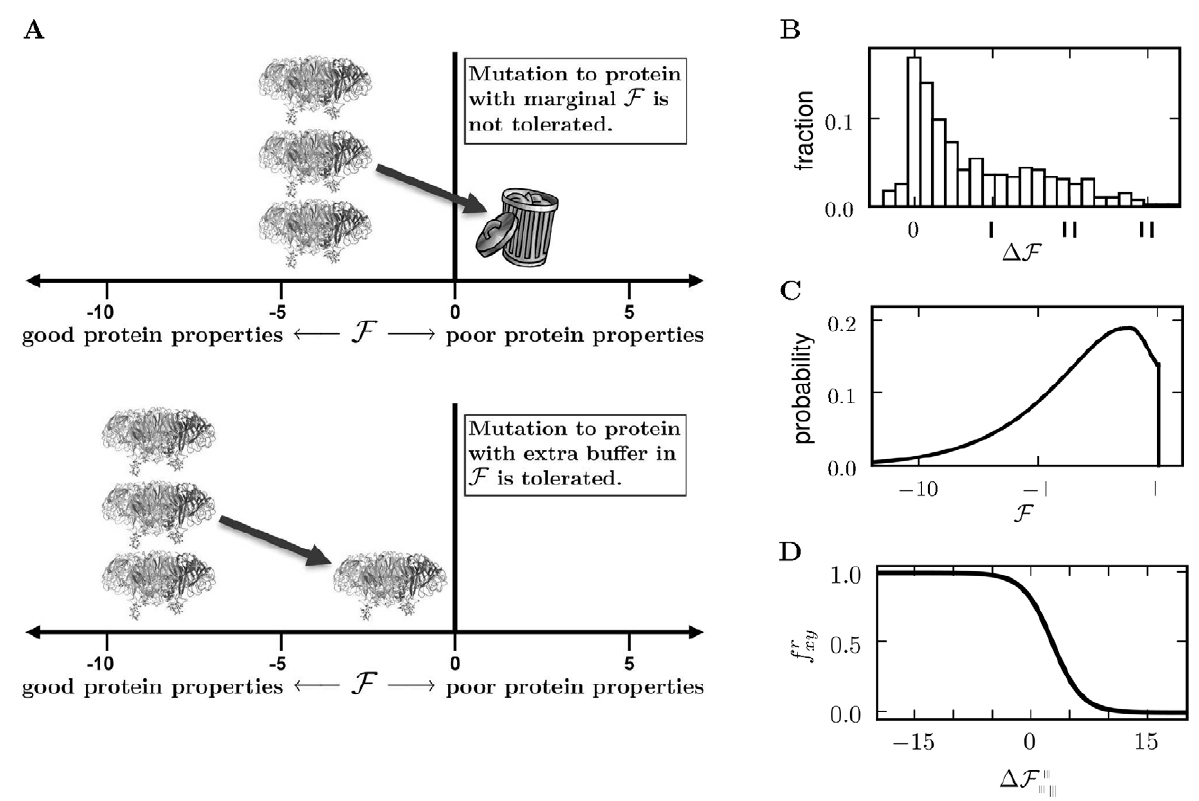
Figure 7. Rationale for assuming that the fixation probability of a mutation depends on its effect on evolutionarily constrained protein properties. (A) Evolution is assumed to select in a threshold manner for properties such as folding, stability, or expression (approximated by the variable F ). A mutation deleterious to F will not be tolerated by a protein that has a marginal value of F (top panel). But the same mutation is tolerated by a protein with an extra buffer in F (bottom panel). (B) Most mutations are deleterious to F , and therefore have positive D F values. Shown is an example distribution of D F for all mutations to a protein, taken from [49]. (C) The time-averaged probability distribution of F for an evolving protein will tend towards values just marginally below the threshold. Shown is an example of this distribution, taken from [49]. (D) As a consequence, mutations with negative D F values will generally be tolerated, but those with positive D F are less likely to be tolerated. Shown is a that mutating residue r from y to x will be tolerated as a function of the associated D F r value, as plot of the relationship between the probability f r xy xy defined in Equation 3.